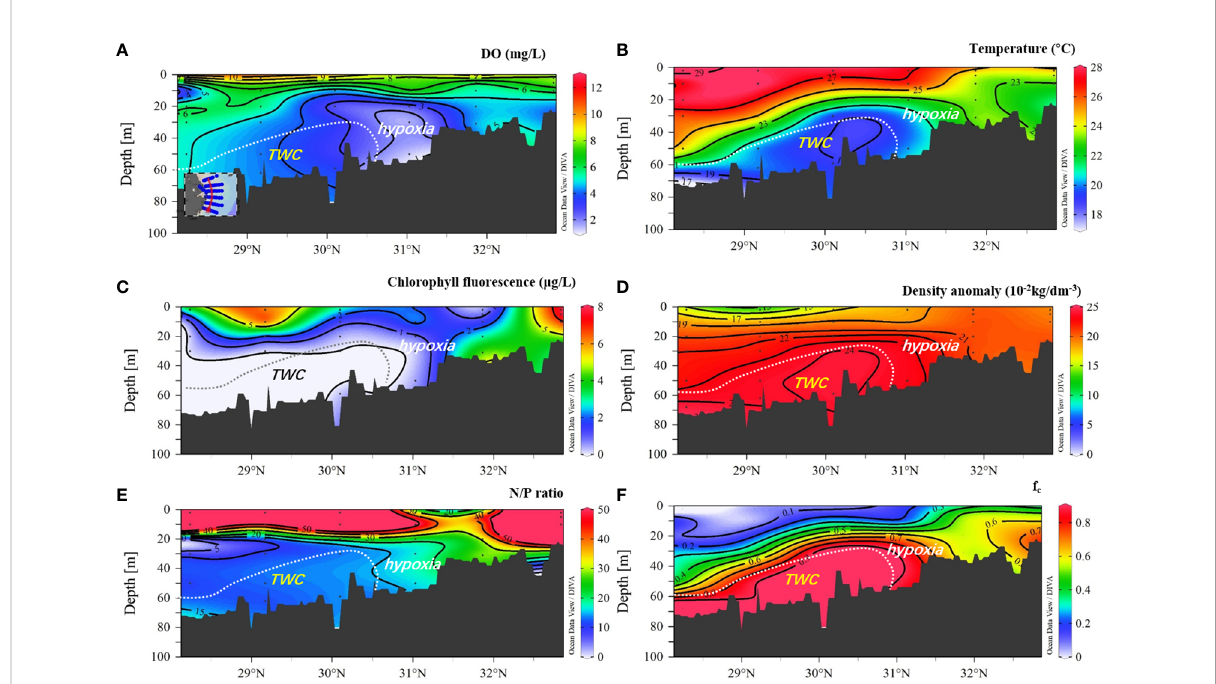
FIGURE 6 Distribution of DO, temperature, chlorophyll fl uorescence, density anomaly, N/P ratio, and fc (fraction of TWC/KSSW) in transect 123°E. (A) DO (mg L − 1 ); (B) temperature; (C) chlorophyll fl uorescence; (D) density anomaly; (E) N/P ratio; and (F) fc (fraction of TWC/KSSW). CDW, Changjiang